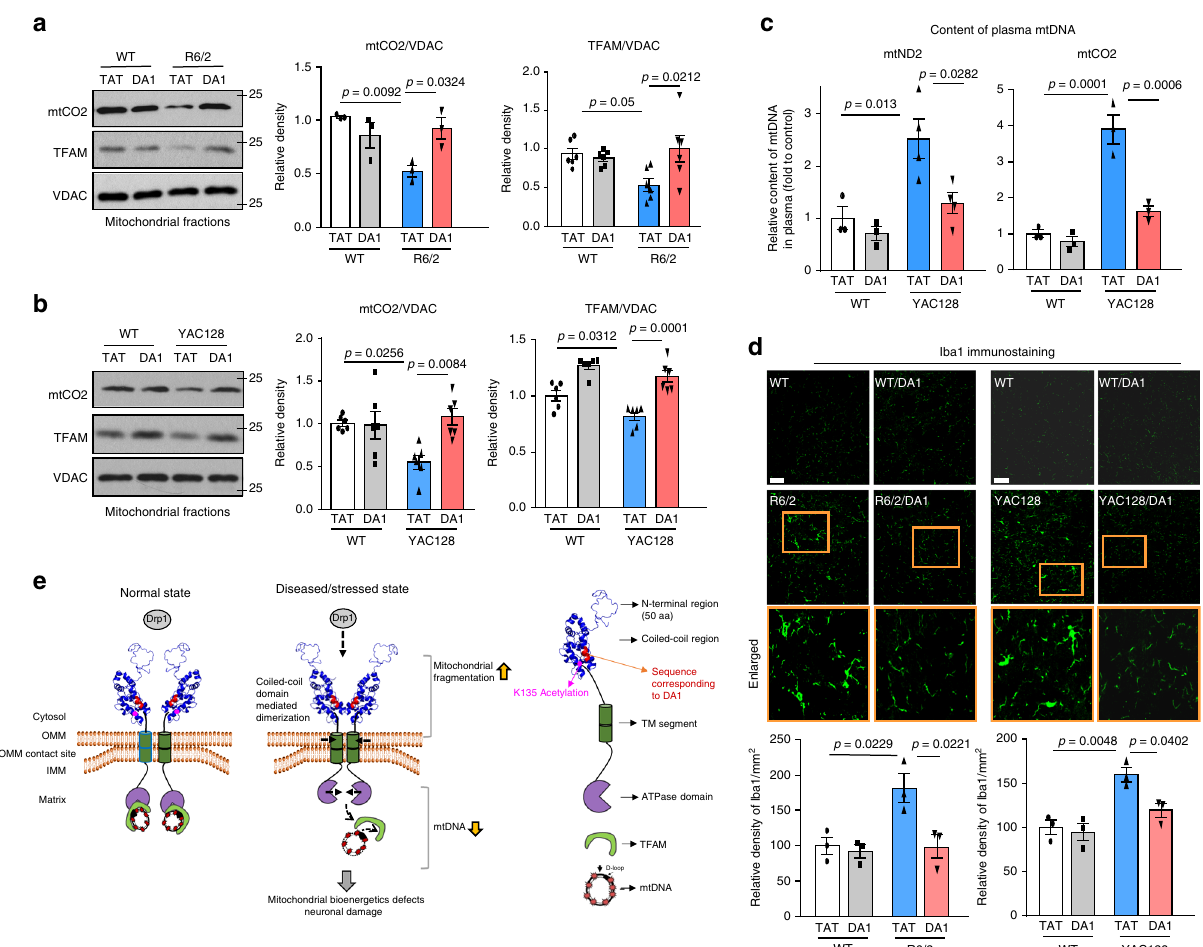
Fig. 8 DA1 treatment reduces mtDNA damage in HD mice. Mitochondria were isolated from striatum of R6/2 or age-matched wildtype mice (12 weeks old) ( a ), and YAC128 or age-matched wildtype mice (6 months old) ( b ). Protein levels of mtCO2 and TFAM were determined by WB. VDAC: a mitochondrial loading control. Histogram: the relative density of mtCO2 and TFAM to VDAC. n = 3 – 6 mice/group. One-way ANOVA with Tukey ’ s post- hoc test. c Plasma samples were harvested from YAC128 mice or wildtype mice (6 months old). The mtDNA content in plasma was examined by qPCR. One-way ANOVA with Tukey ’ s post-hoc test. n = 6 mice/group. d Brain coronal sections (10 µ m) of R6/2 (left, 12 weeks old) or YAC128 (right, 6